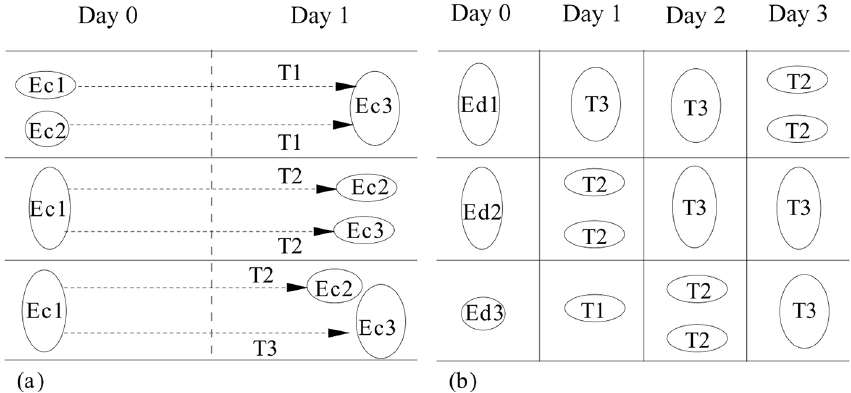
Figure 7. (a) Three typical cases of successors (T1, T2, and T3) from one day (day 0) to another (day 1). (b) The eddy at day 0 may have different successors corresponding to different numbers of “look-ahead” days; e.g., Ed1 at day 0 may have a T3 eddy on day 2 and have two T2 eddies on day 3.